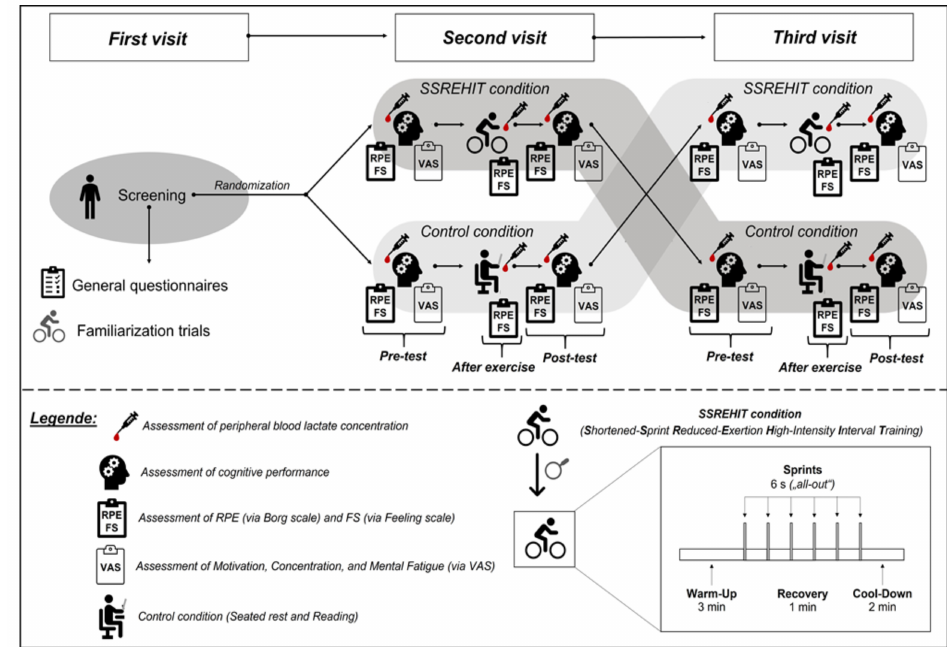
Figure 1. Schematic illustration of the study procedures. FS: Feeling scale, min: minute(s), s: seconds, SSREHIT: shortened-sprint reduced-exertion high-intensity interval training, RPE: Rating of Perceived Exertion (via Borg scale), and VAS: Visual Analogue